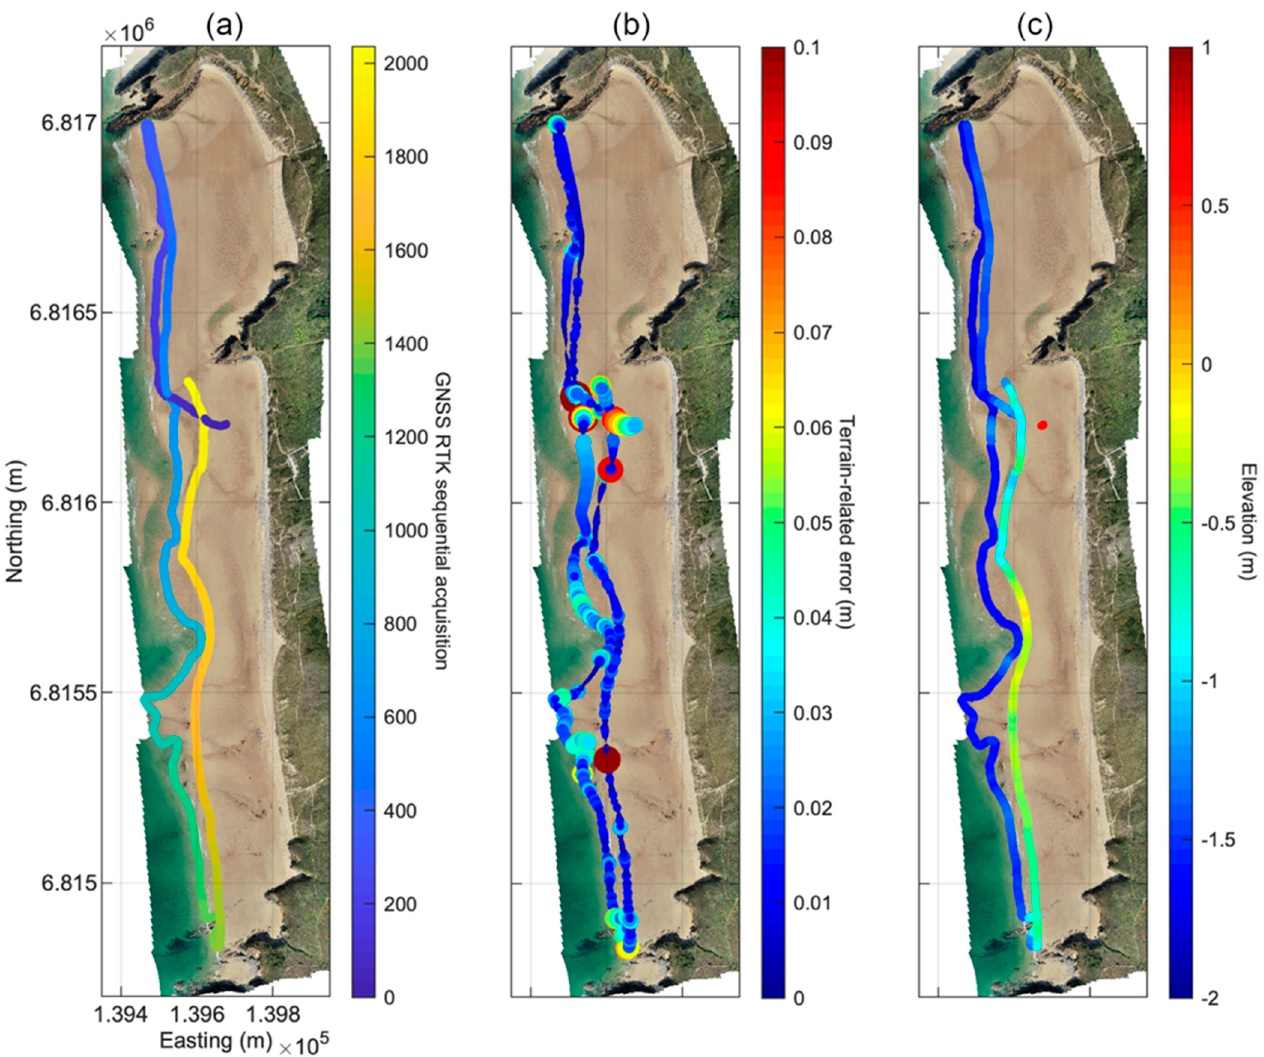
Figure 4. Verification of survey points obtained using a bike-mounted RTK-GNSS at La Palue, with ( a ) the chronology of point acquisition; ( b ) pitch-related horizontal error (dx), where marker size is proportional to error magnitude (×1000 magnification factor) and ( c ) the elevation of survey points retained serving as ground truths for photogrammetric evaluation.